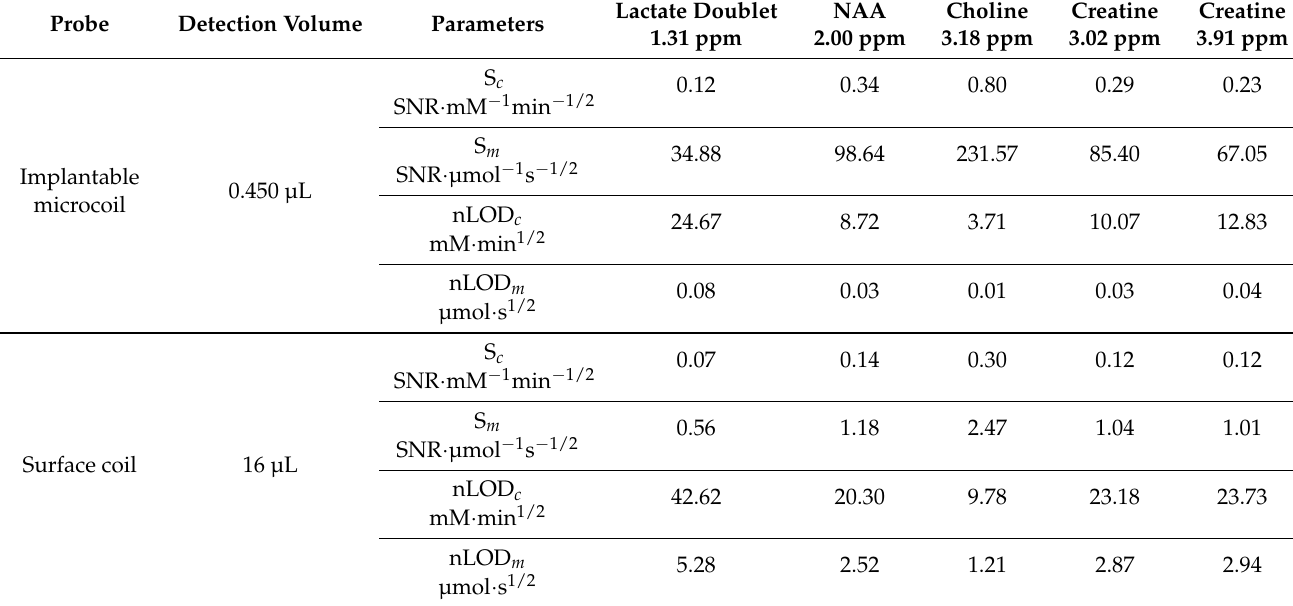
Table 1. Sensitivities, S c and S m , and limits of detection, nLOD c and nLOD m , for the implantable microcoil and the surface coil measured for five resonance lines.